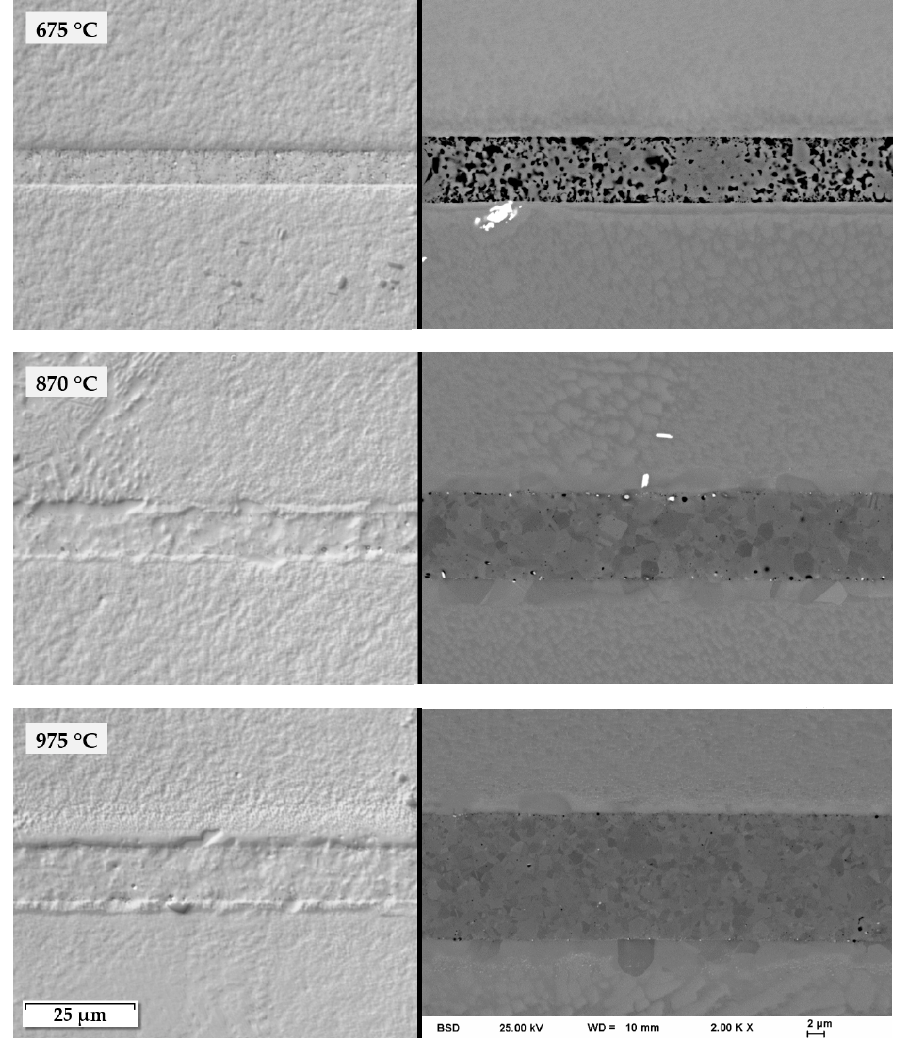
Figure 7. Microstructure of joining seams of Alloy 247 DS joined with Ni90_PEG at different tem- peratures with a holding time of 510 s (8.5 min) and a pressure of 23.3 MPa, light microscope ( left ) and SEM ( right ).